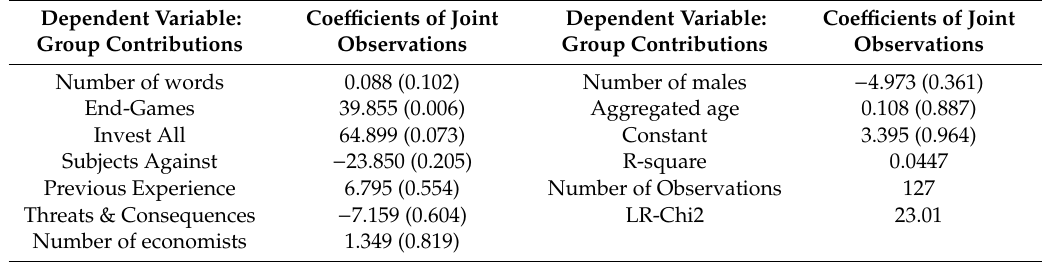
Table 6. Results of Tobit regression of group contributions with p-values denoted in